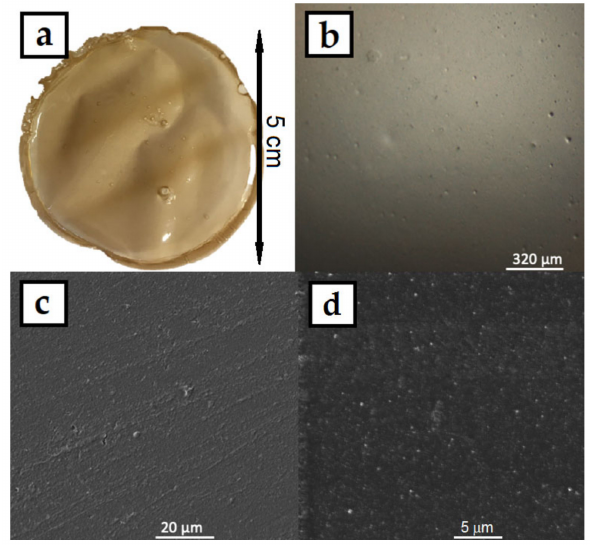
Figure 5. ( a ) Photograph, ( b ) CLSM and ( c , d ) SEM micrographs of AgNPs in HPMC composite foil